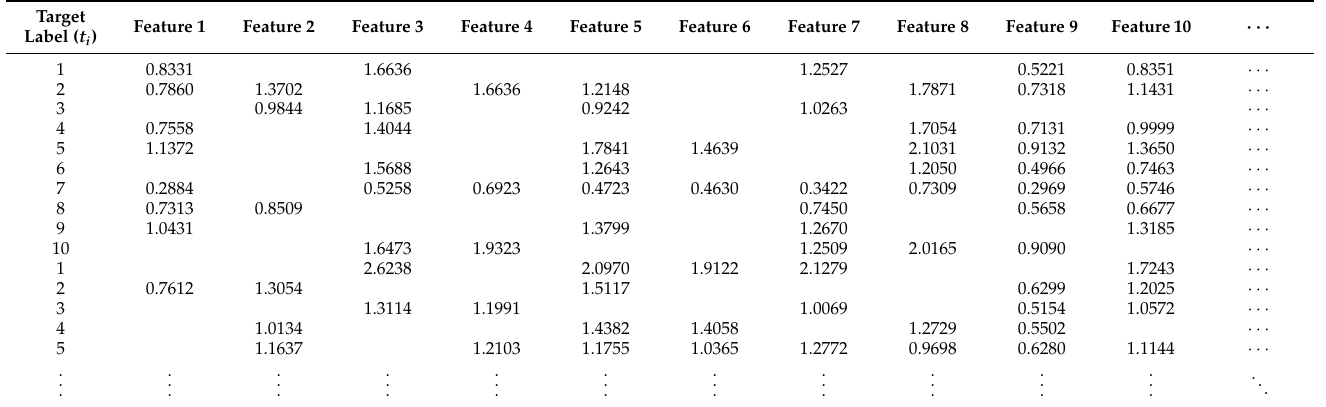
Table 4. The partially annotated matrix D .